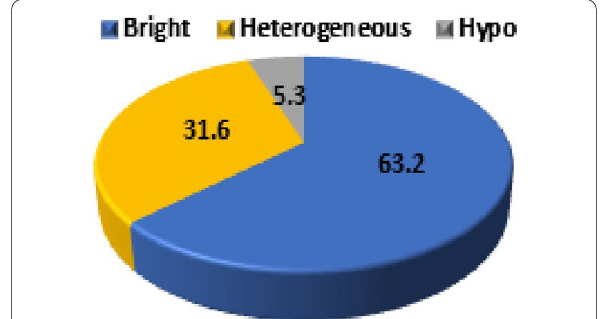
Fig. 3 Pie Chart showing the signal intensity of the entire ablation zone in the non‑enhanced T1 images